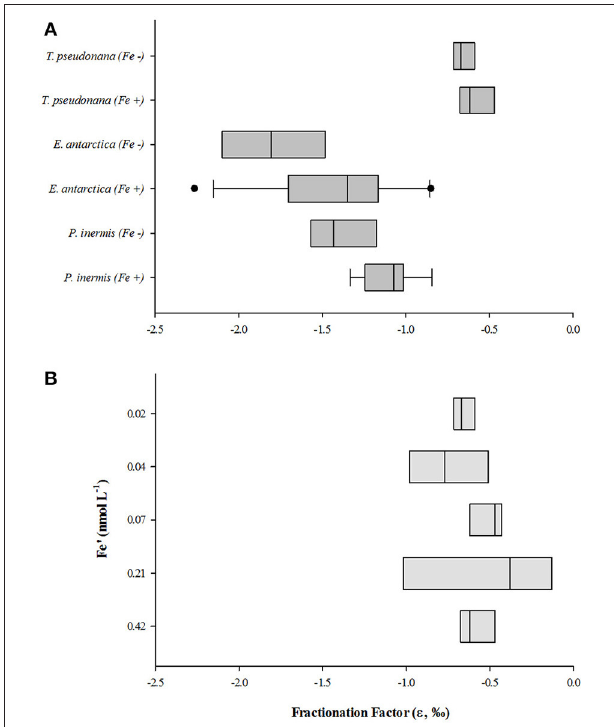
FIGURE 2 | Box and whisker plot displaying the effects of Fe-availability on T. pseduonana , P. inermis and E. Antarctica . (A) Represents comparisons between all species, (B) represents the variation in Si-isotope fractionation factor across multiple Fe-concentrations for T. pseudonana . Lines are median values, Boxes represent 1st and 3rd quartiles and dots represent outliers ( n ≥